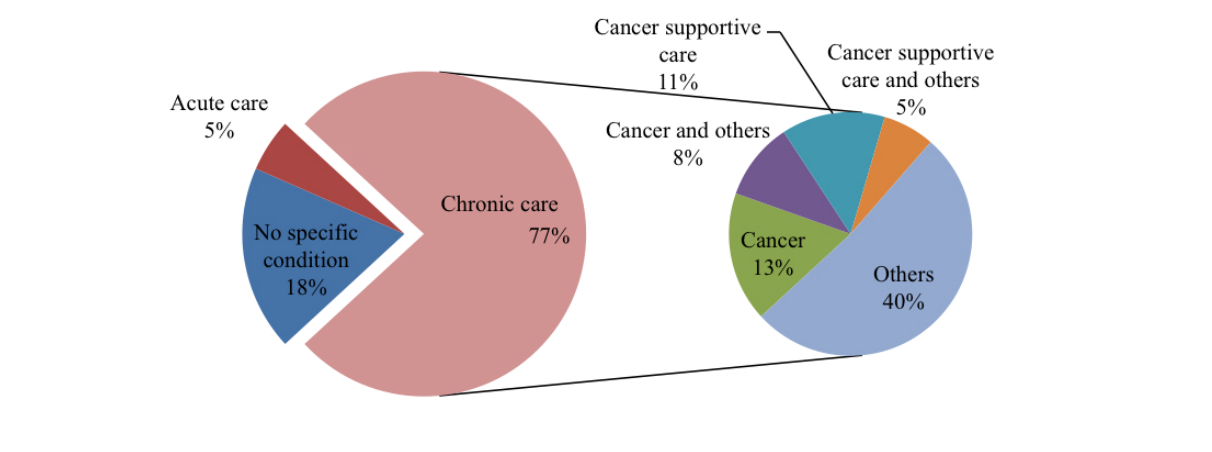
Figure 3. Health